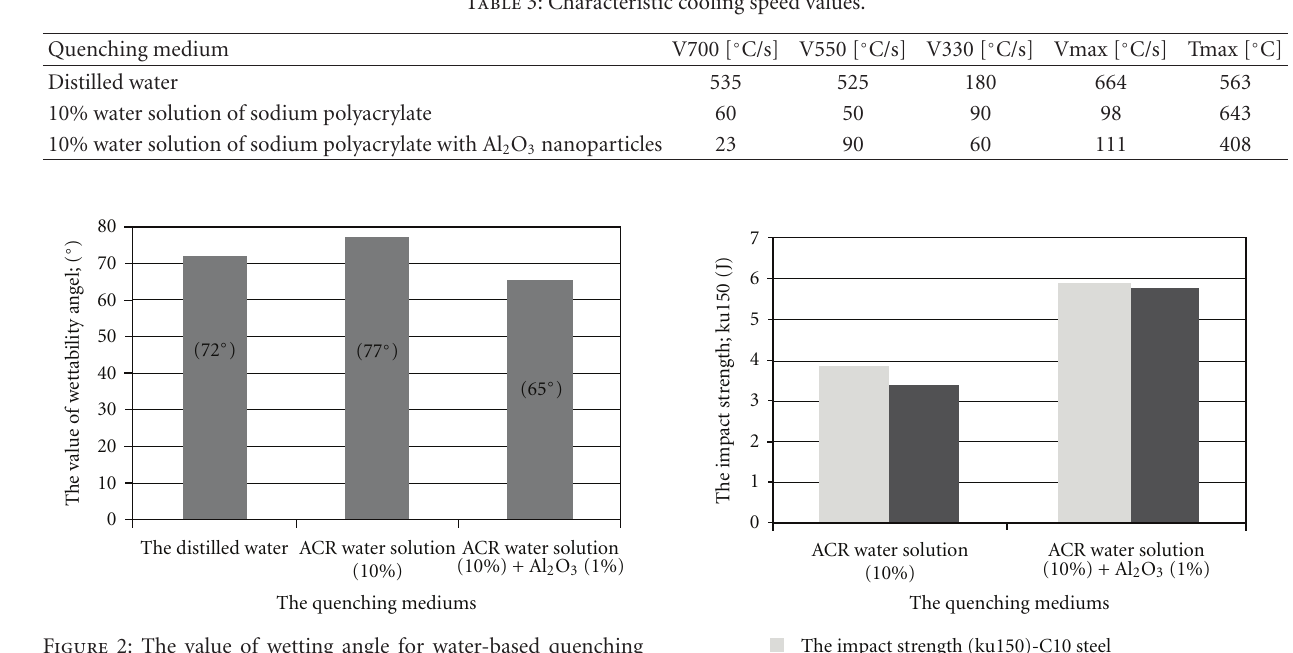
Figure 2: The value of wetting angle for water-based quenching media.